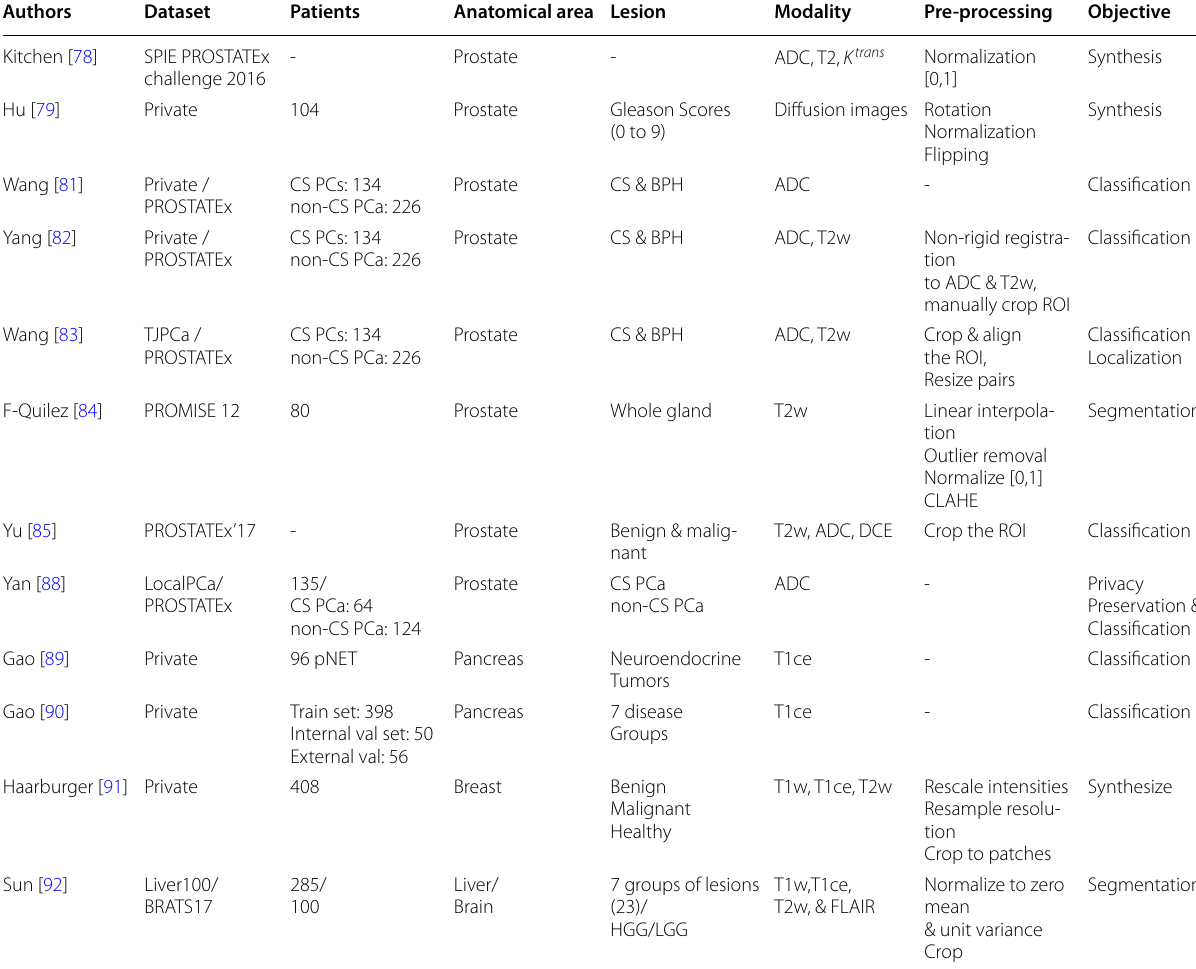
ADC, Apparent Diffusion Coefficient; CS, Clinically Significant; PCa, Prostate Cancer; T2w, T2-weighted; DCE, Dynamic Contrast Enhanced; BPH, Benign Prostatic Hyperplasia; ROI, Region of Interest; pNET, pancreatic Neuroendocrine Tumor; T1ce, T1 contrast-enhanced; val, validation; LGG, Low-Grade Gliomas; HGG, High-Grade Gliomas; FLAIR, fluid-attenuated inversion recovery; Symbol ’-’ represents that the corresponding information was not provided in the